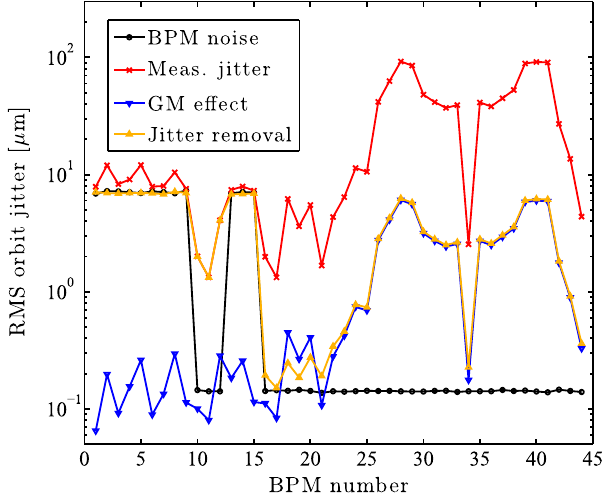
FIG. 5. Vertical RMS orbit jitter at the BPM locations due to different contributions compared to the BPM